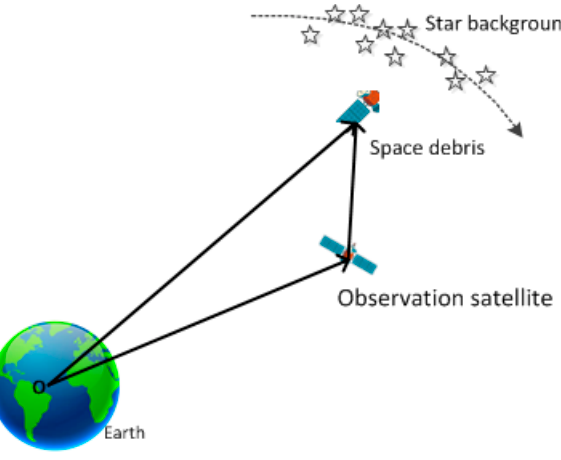
Figure 3. Observation diagram.